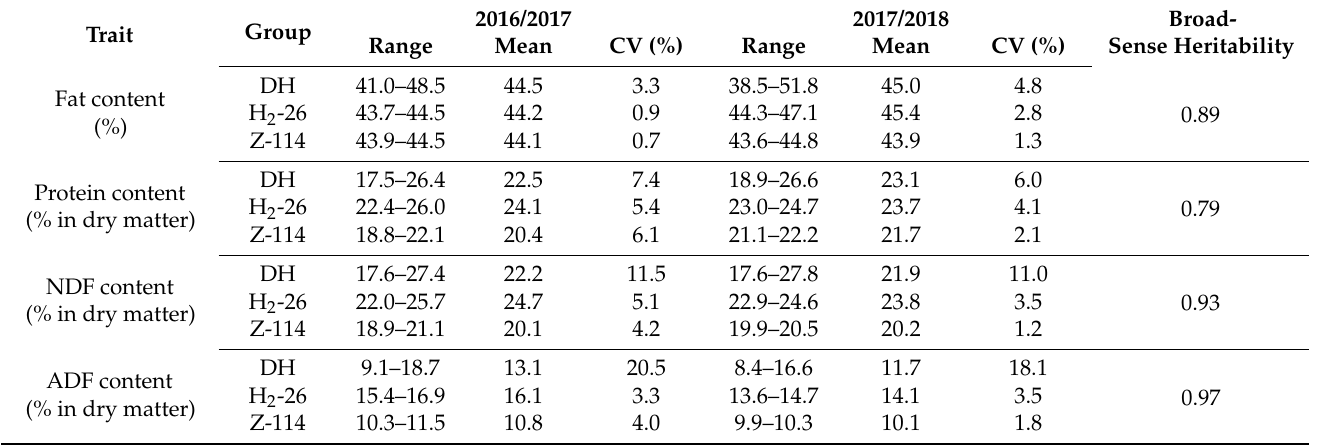
Figure 3. The profiles of main seed compounds in each individual DH line and two parental oilseed rape lines included in the study. The population mean was also shown. 3.2. Correlation between Fat, Protein, NDF, ADF and GSL Content and Seed Colour